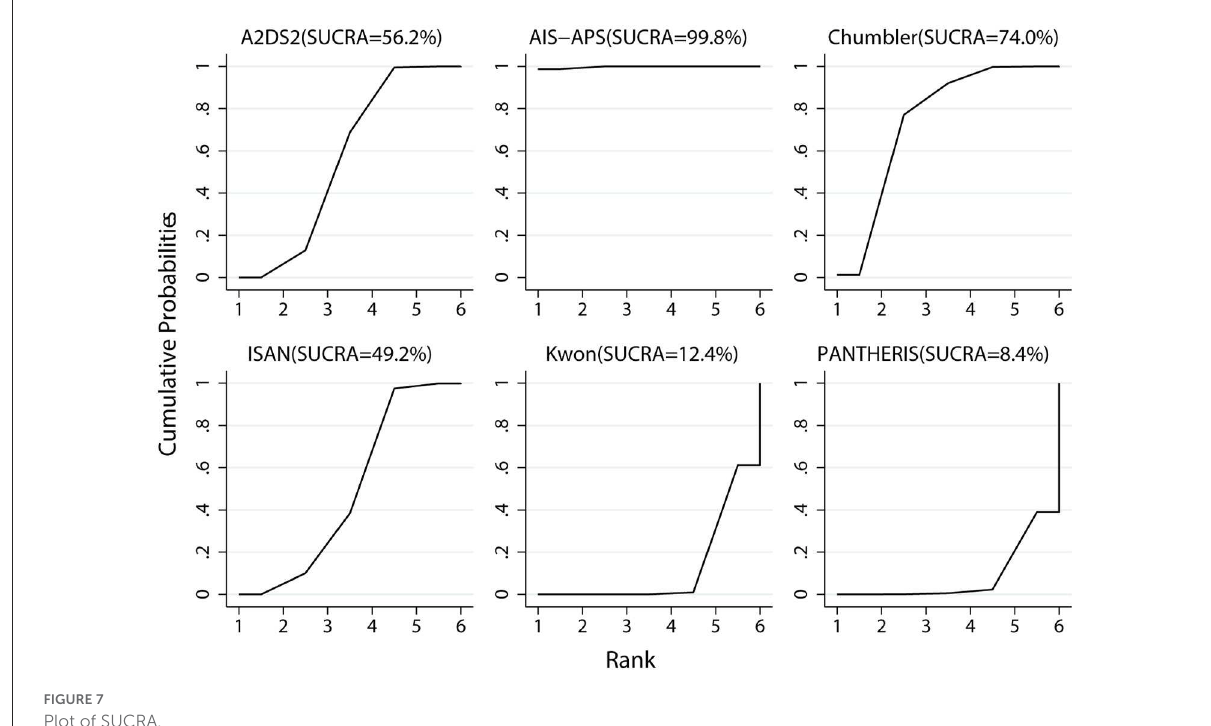
FIGURE7 Plot of SUCRA.